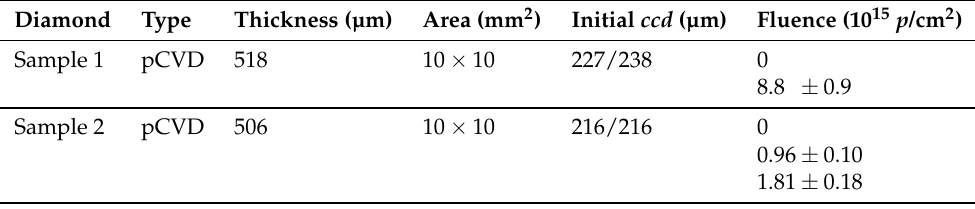
Table 1. Properties of diamonds irradiated with 70MeV protons and the fluence they received. The initial unirradiated Charge Collection Distance ( ccd ) values are given separately for positive and negative bias polarity ( E = 2V/µm). ±